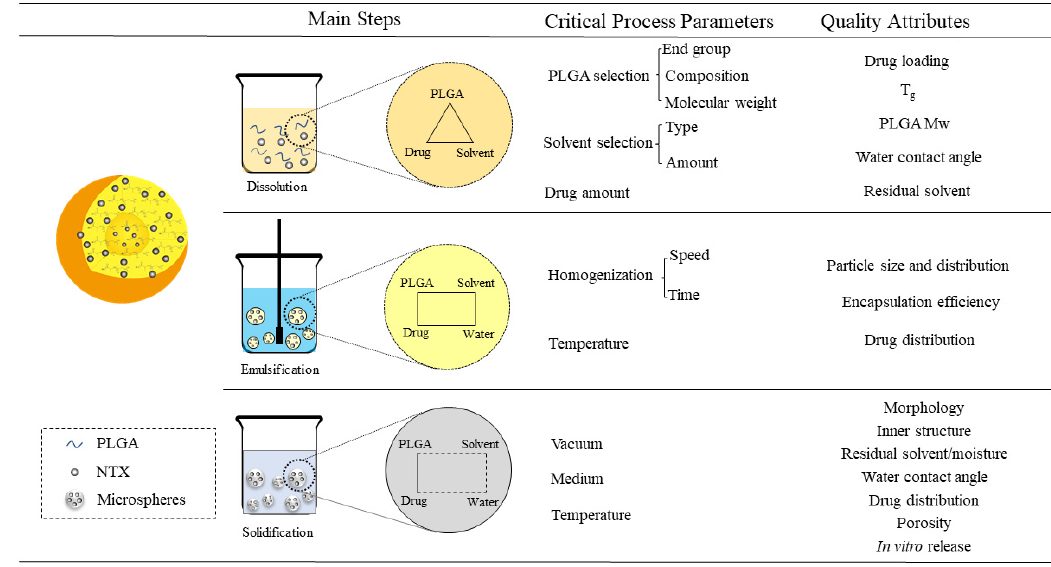
Figure 1. The critical process parameters and corresponding quality attributes of poly(lactide-co-glycolide) (PLGA) microspheres in the main manufacturing process. The quality attributes were obtained from the reverse engineering of Vivitrol ® , and promoted the identification of key process parameters. NTX: naltrexone, Mw: the weight-average molecular weight.